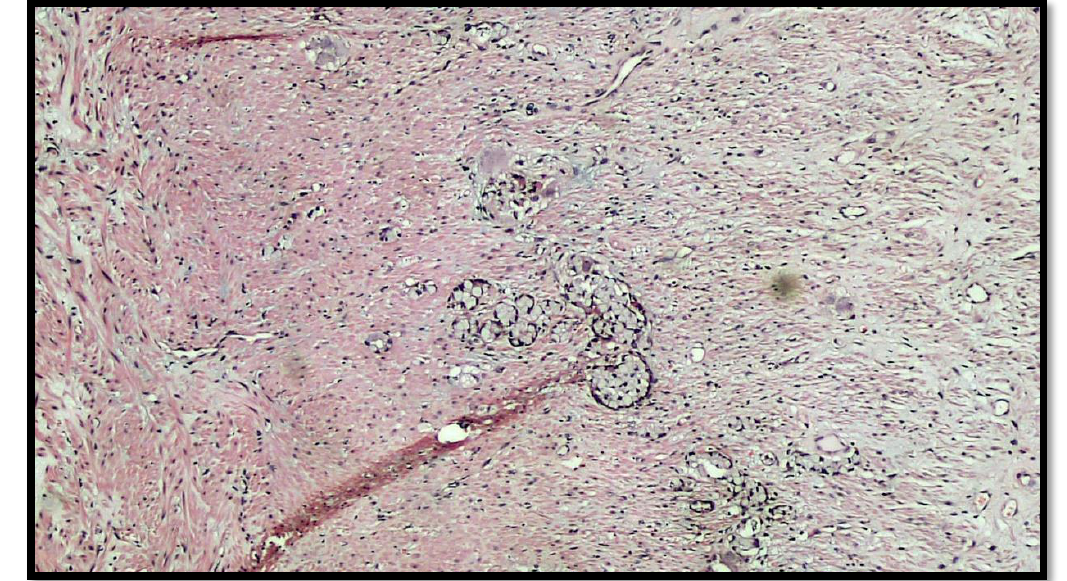
Figure 4. Details of muscular invasion by GCC of the appendix (hematoxylin – eosin, original mag- nification 20×).